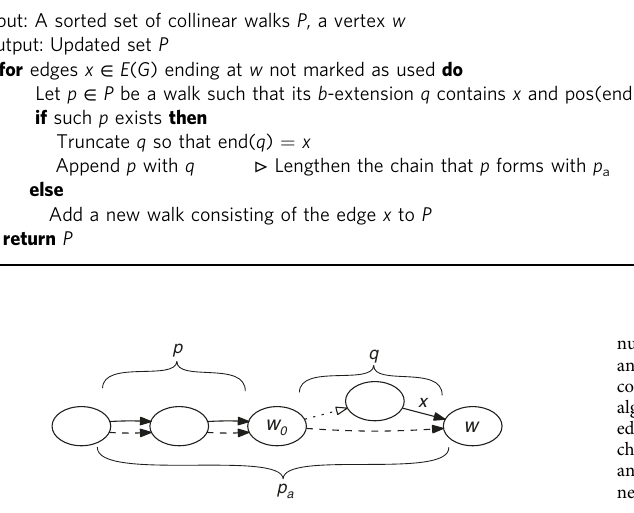
Fig. 6 Illustration for Algorithm Update-collinear-walks (Box 2). A collinear walk p (solid) requires an update after the carrying path p a is extended with the dashed edge ( w 0 , w ). The path p a now ends at the vertex w , which has another incoming edge x . Since x is a part of the b -extension of p (denoted by q ), p can be appended with q to form a longer chain and boost the collinearity score.